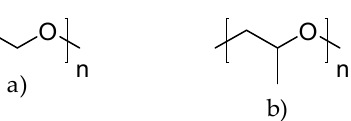
Figure 13. ( a ) Poly(ethylene glycol) (PEG) and ( b ) poly(propylene glycol) (PPG). These polymers are often used as the hydrophilic part of amphiphilic copolymers.